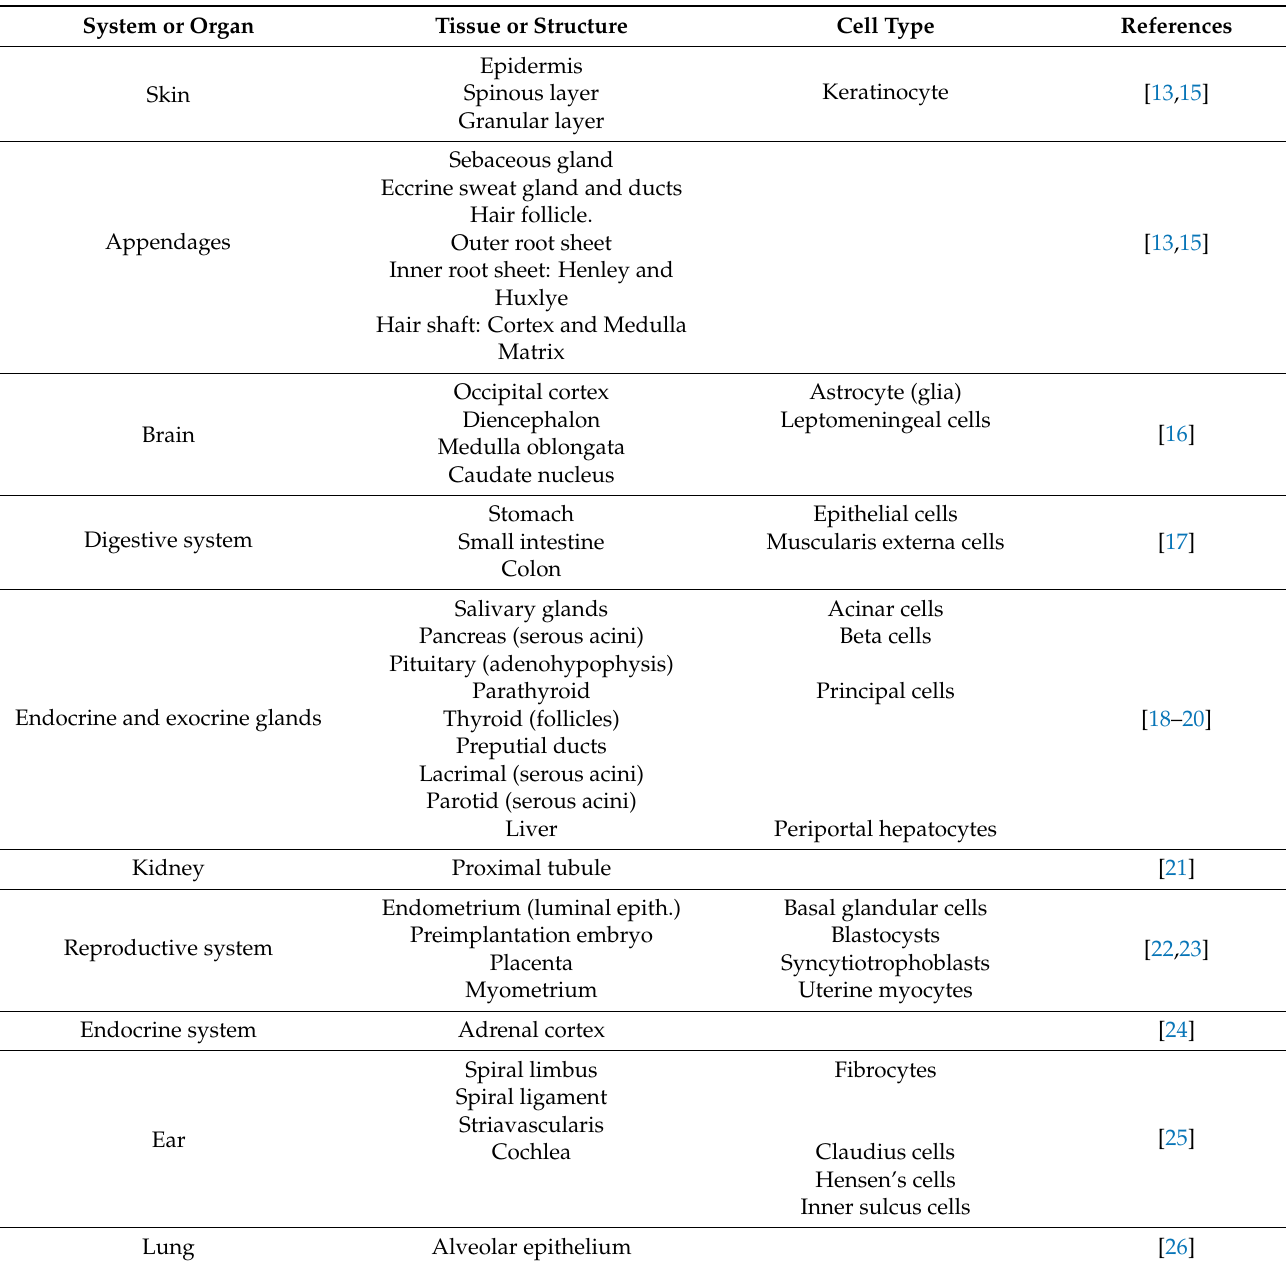
Table 1. Expression of CX26 in human